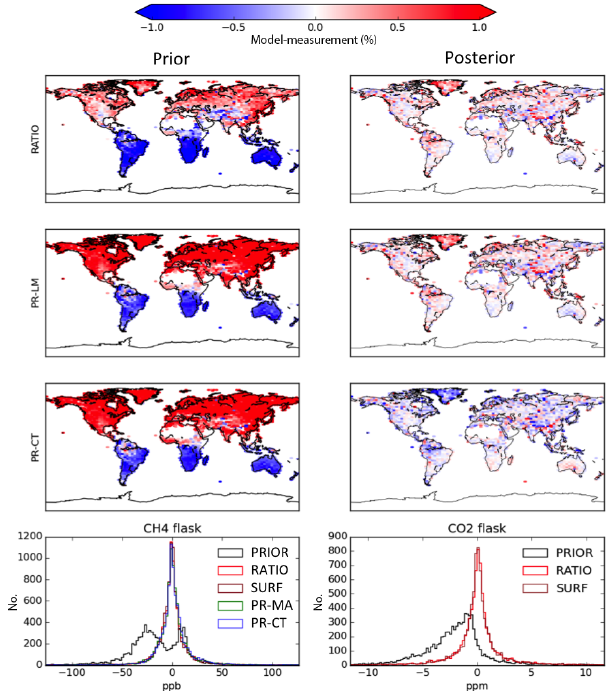
Figure 2. Fit residuals, comparing the performance of different in- versions. The top three rows show the difference between TM5– 4DVAR and GOSAT measurements (X ratio for RATIO, XCH proxy for PR-CT and PR-MA), using a priori (left) and a posteriori (right) fluxes. The bottom row shows histograms of measurement–model mismatches between TM5–4DVAR and NOAA surface measure- ments in 400 bins between ± 10 σ range of the a priori